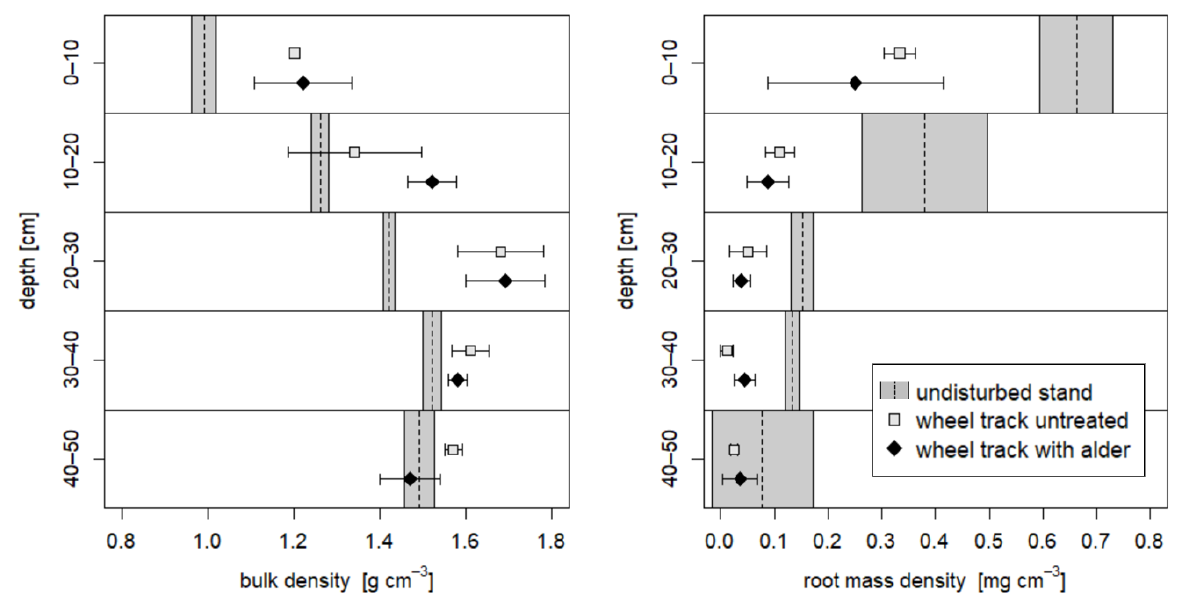
Figure 2. Median values of bulk density ( left ) and fine root mass density ( right ) in the undisturbed beech stand (dashed lines) and on the wheel tracks of the skid trails 10 years after soil trafficking. The grey shading and error bars indicate the 95% confidence intervals of median values.